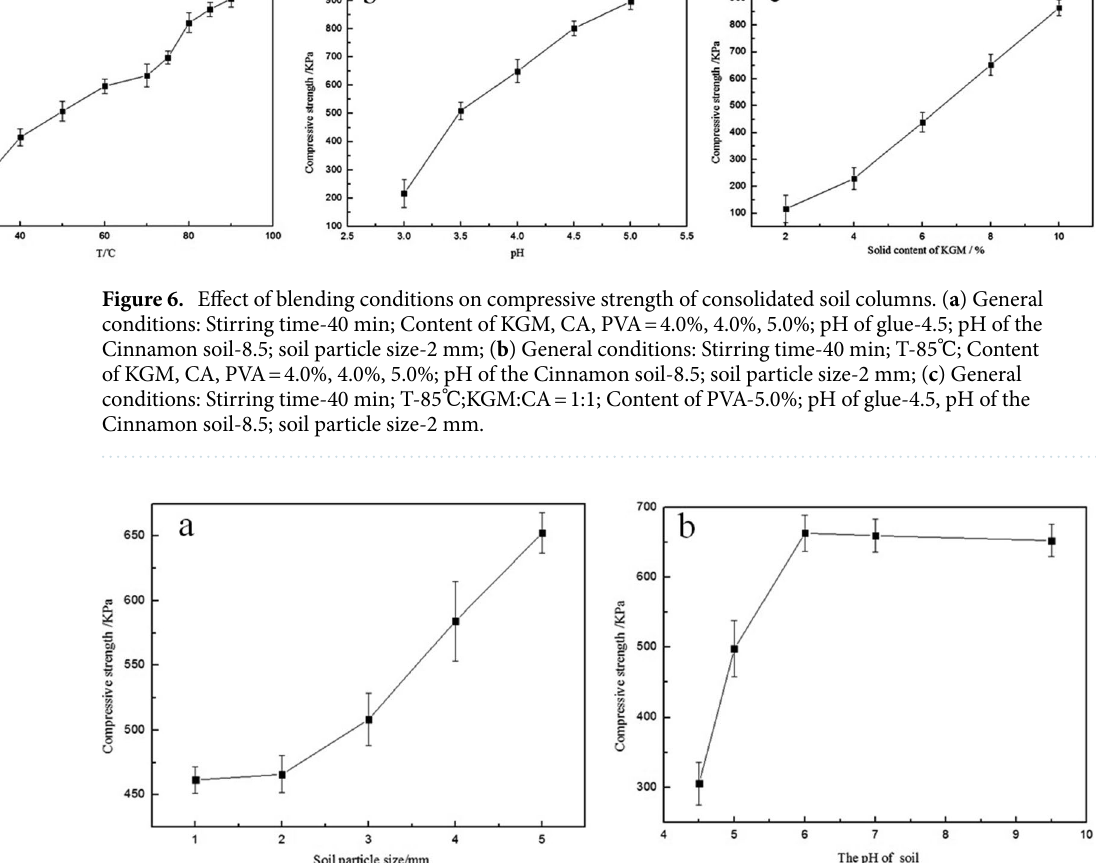
Figure 7. Effect of soil particle size and soil pH on compressive strength of consolidated soil column. ( a ) General conditions: Stirring time-40 min; T-85 ℃ ; Content of KGM, CA, PVA = 4.0%, 4.0%, 5.0%; pH of glue- 4.5, pH of the Cinnamon soil-8.5; ( b ) general conditions: Stirring time-40 min; T-85 ℃ ; Content of KGM, CA, PVA = 4.0%, 4.0%, 5.0%; pH of glue-4.5, soil particle size-2